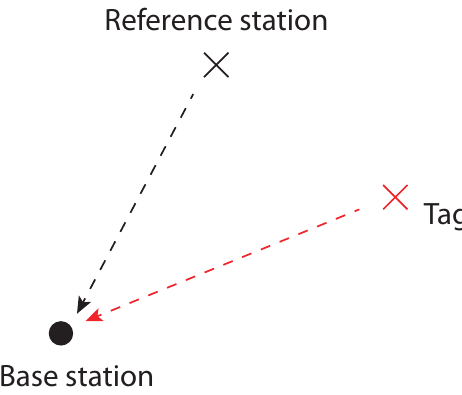
Figure 2. The messages transmitted with the Abatec Local Position Measurement (LPM) system are represented by the dashed lines. The black circle is the base station, the black cross the reference station, and the red cross the